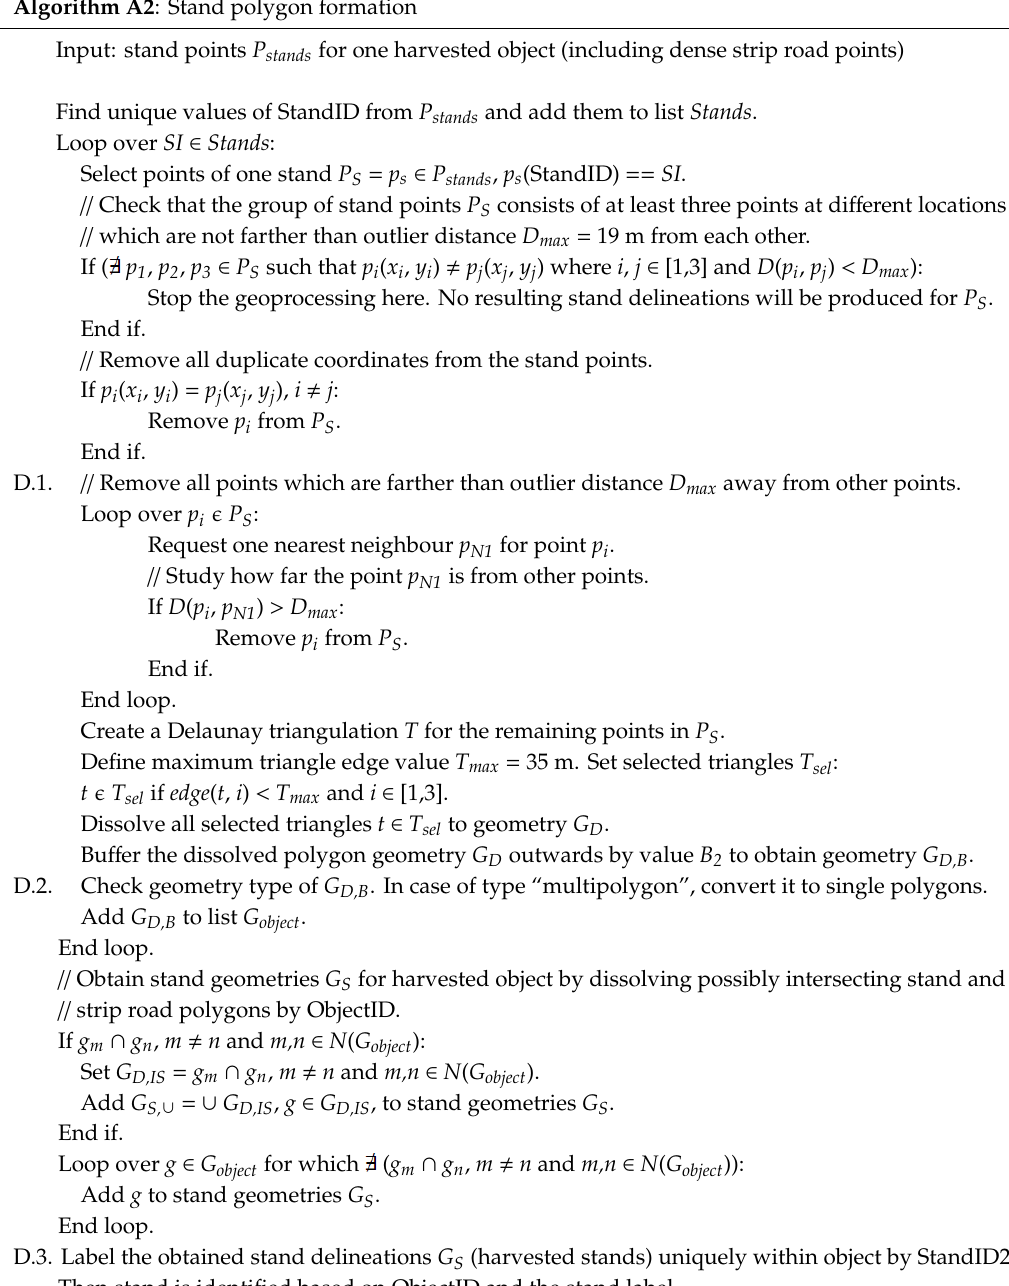
Algorithm A2 : Stand polygon